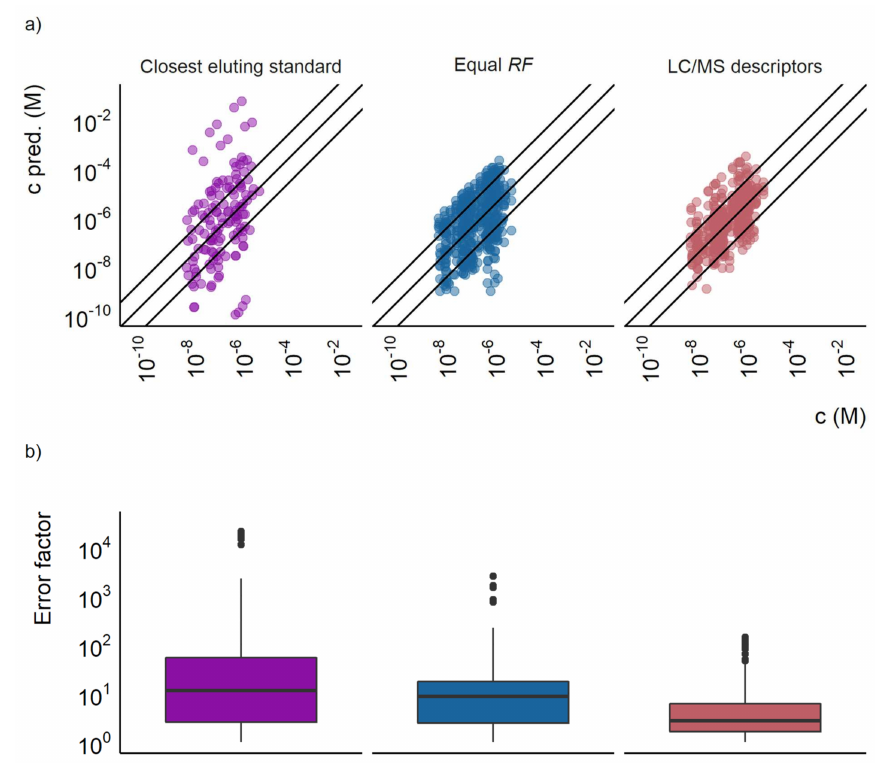
Figure 1. ( a ) The predicted concentration plotted against the actual concentration for the closest eluting standard approach, the equal response factor approach (equal RF ), and the LC/MS descriptors models. Each point represents a compound at a certain concentration, the outer lines show a prediction error of a factor of 10 and the middle line show where the predicted and true concentrations are equal. ( b ) A box plot showing the prediction error of the closest eluting compound approach, the equal response factor approach, and the LC/MS descriptors